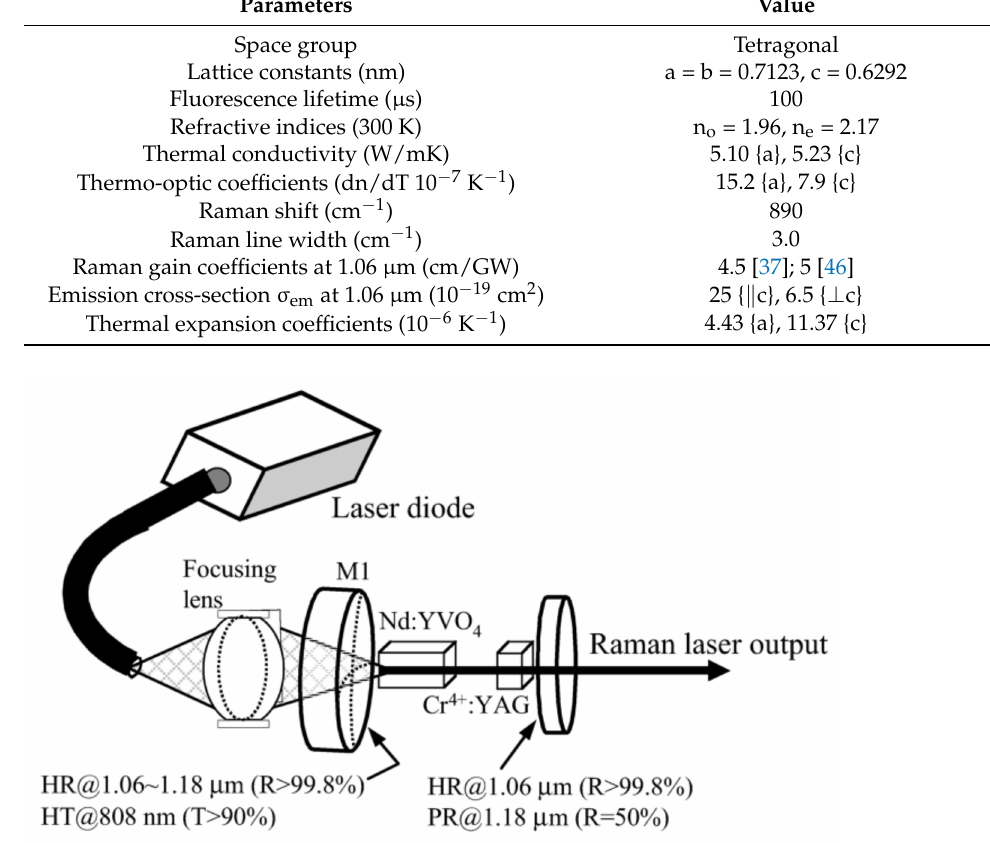
Figure 1. Schematic of the passively Q-switched Nd:YVO 4 self-Raman laser